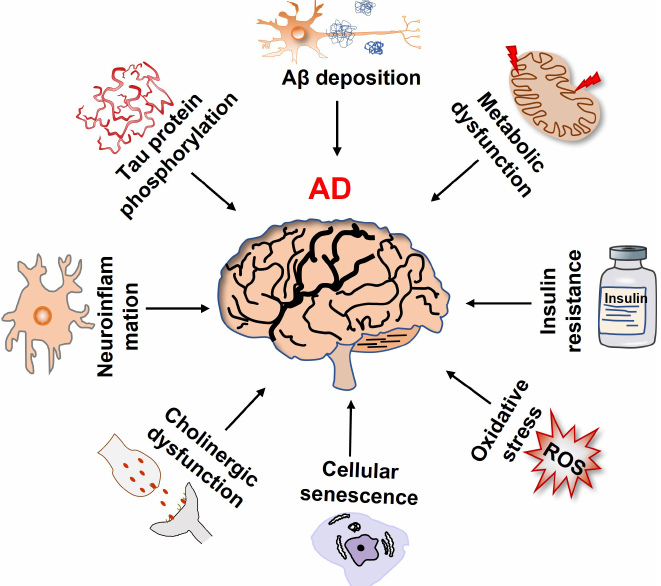
Figure 1. Multiple factors that contribute to the onset and progression of Alzheimer’s